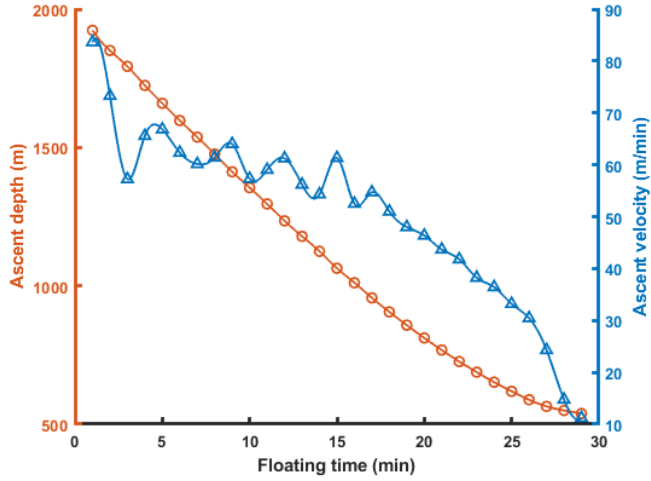
Figure 19. Relationship curve of ascent depth versus time and ascent velocity versus time.